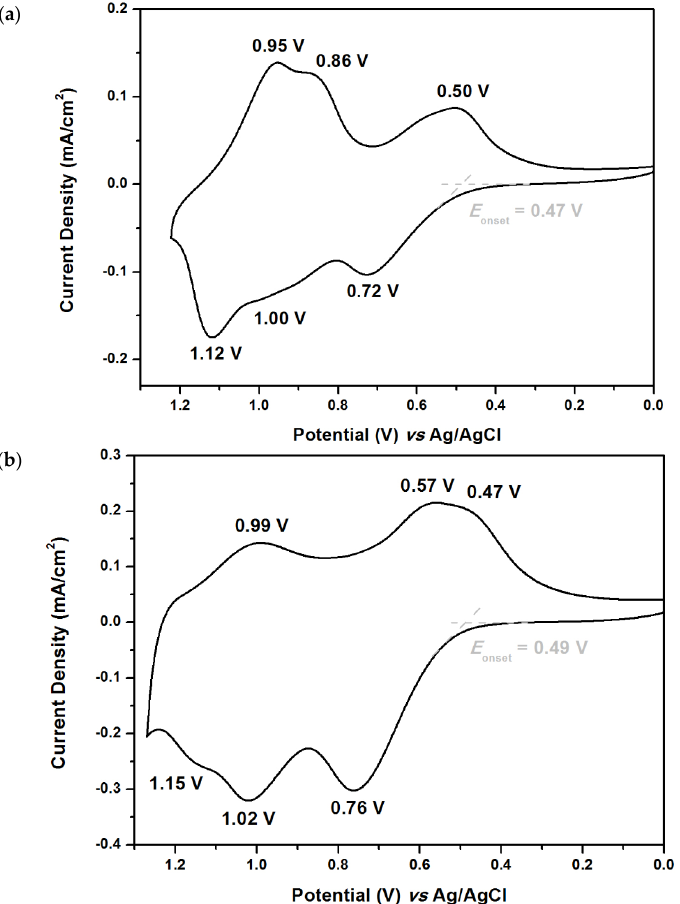
Figure 8. Cyclic voltammograms and differential pulse voltammograms of polymer films ( a ) P1 and ( b ) P2 on the ITO-coated glass slide in 0.1 M Bu 4 NClO 4 /CH 2 Cl 2 at a scan rate of 50 mV·s −1 . Table 1. Optical and electrochemical properties of the electrochemically synthesized polymers.